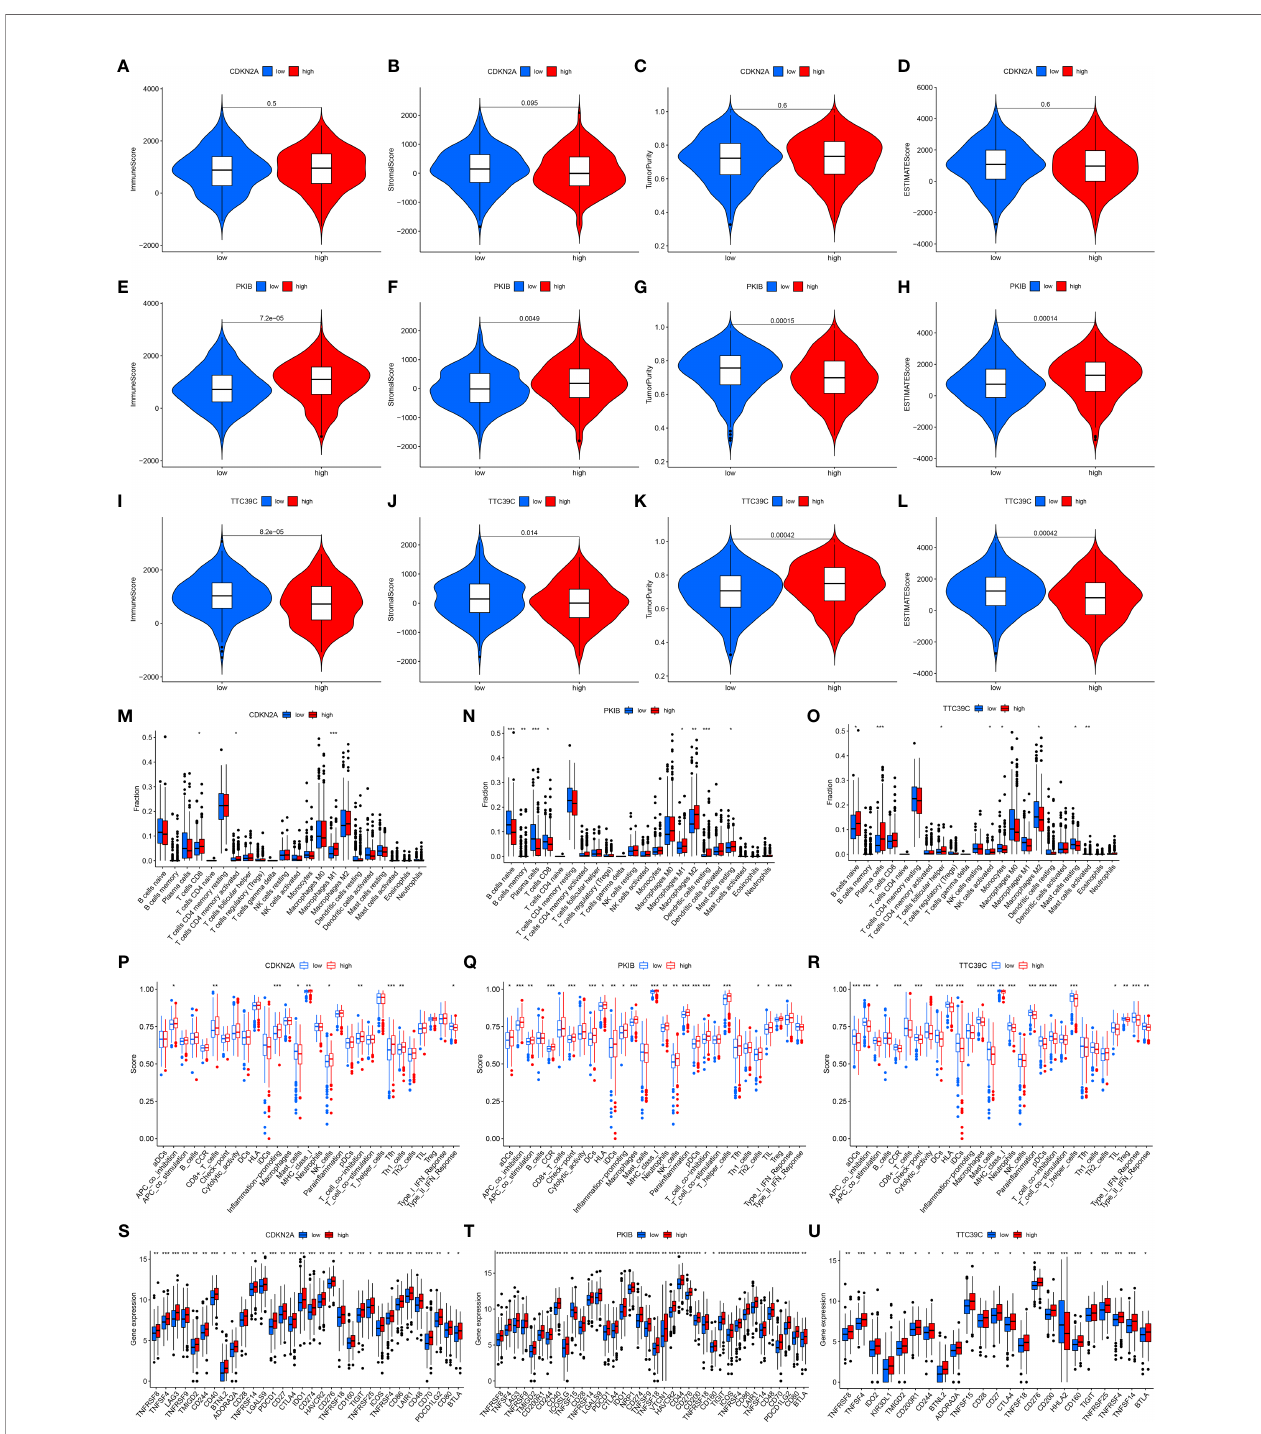
FIGURE 8 | Associations of prognostic AS events-related genes with immune response and immune cell in fi ltration. (A – D) Violin plots depicted the distribution of estimate, immune, and stromal score as well as tumor purity in high and low CDKN2A groups. (E – H) Violin plots depicted the distribution of estimate, immune, and stromal score as well as tumor purity in high and low PKIB groups. (I – L) Violin plots depicted the distribution of estimate, immune, and stromal score as well as tumor purity in high and low TTC39C groups. (M – O) The distribution of the abundance levels of tumor-in fi ltrating immune subpopulations in high and low expression of CDKN2A, PKIB, and TTC39C groups. (P – R) The distribution of the abundance levels of immune cell in fi ltrations and immune functions in high and low expression of CDKN2A, PKIB, and TTC39C groups. (S – U) Expression levels of immune checkpoint related genes in high and low CDKN2A, PKIB, and TTC39C subpopulations. *P < 0.05; **p < 0.01; ***p <